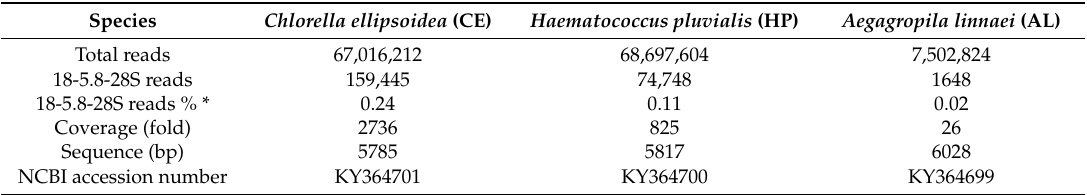
Table 1. Summary of three algae species tested in this